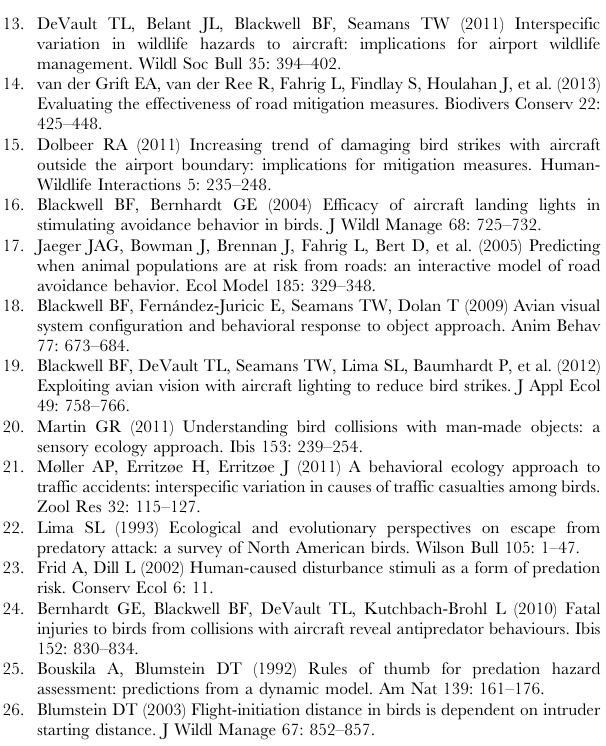
Figure S1 Aerial image of NASA Plum Brook Station in north-central Ohio, USA, and locations of four road sections (on the perimeter of the property) where vehicle approaches were made towards turkey vultures feeding along roads. The diagram at right represents measurements for each road section. (TIF) Figure S2 Road-level view of Ford F-250 with fabric screen mounted to cover front of truck to reduce unintended glare. (TIF) File S1 Supplementary field methods.